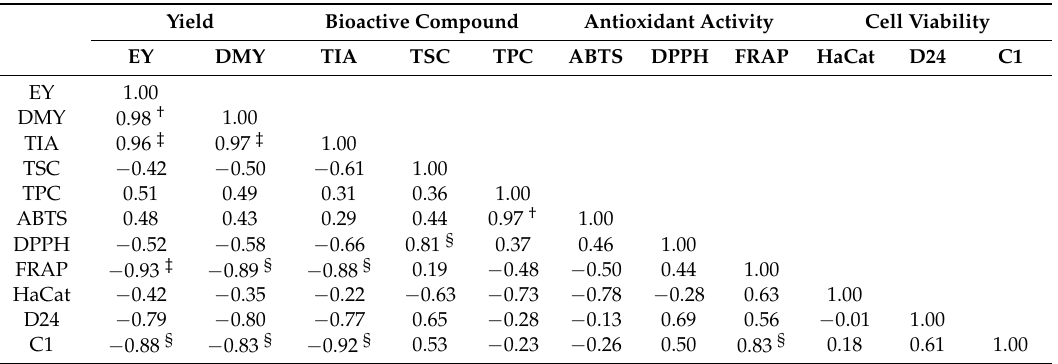
Table 3. Coefficient of correlations ( r ) between yields, bioactive compounds, antioxidant activity, and cell viability across the Gac seed crude extracts.